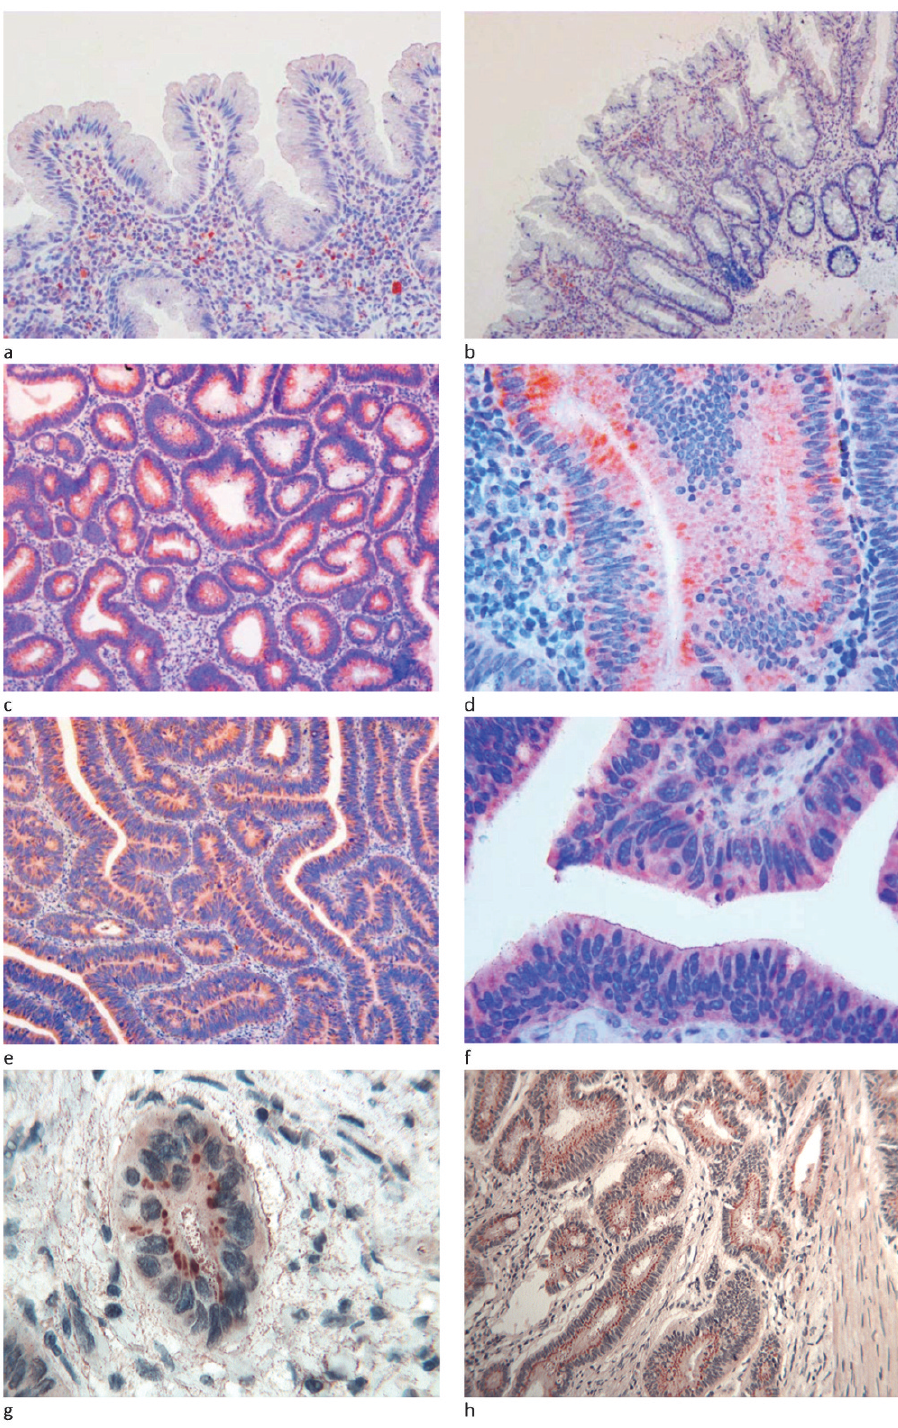
Figure 1 - Hyperplastic and serrated hyperplastic polyps: A), B) No immunoreactivity for T b 4 was observed in hyperplastic and serrated hyperplastic glands of the polyps analyzed. Scattered mast cells showed an intense and granular positivity for T b 4 (OM X250 and X 100). Adenoma with low-grade dysplasia: C) at low magnification, the diffuse cytoplasmic immunoreactivity for T b 4 was restricted to the dysplastic crypt epithelium (OM x100); D) at higher magnification, three main patterns of reactivity for T b 4 were observed in the dysplastic glands: perinuclear spots, cytoplasmic granules and homogeneous cytoplasmic immunostaining (OM x400); adenoma with high-grade dysplasia: E) at low magnification, intense cytoplasmic immunoreactivity for T b 4 was observed in the cytoplasm of dysplastic cells (OMX100); F) at higher magnification, diffuse and homogeneous T b 4 immunoreactivity was observed in the cytoplasm of dysplastic glands (OMx400); adenocarcinoma: G) at higher magnification, peri-nuclear spot-like reactivity for T b 4 was observed in the cytoplasm of the neoplastic nest (OMx400); H) perinuclear spot-like reactivity for T b 4 was observed in the cytoplasm of the infiltrating tumor glands. Fine granular immunoreactivity was detected in the stroma surrounding the infiltrating tumor glands